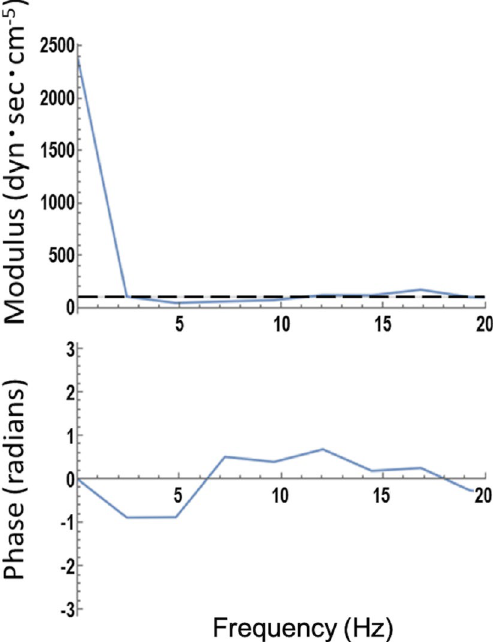
Figure 3. Representative example of aortic input impedance modulus and phase. Dashed line shows characteristic